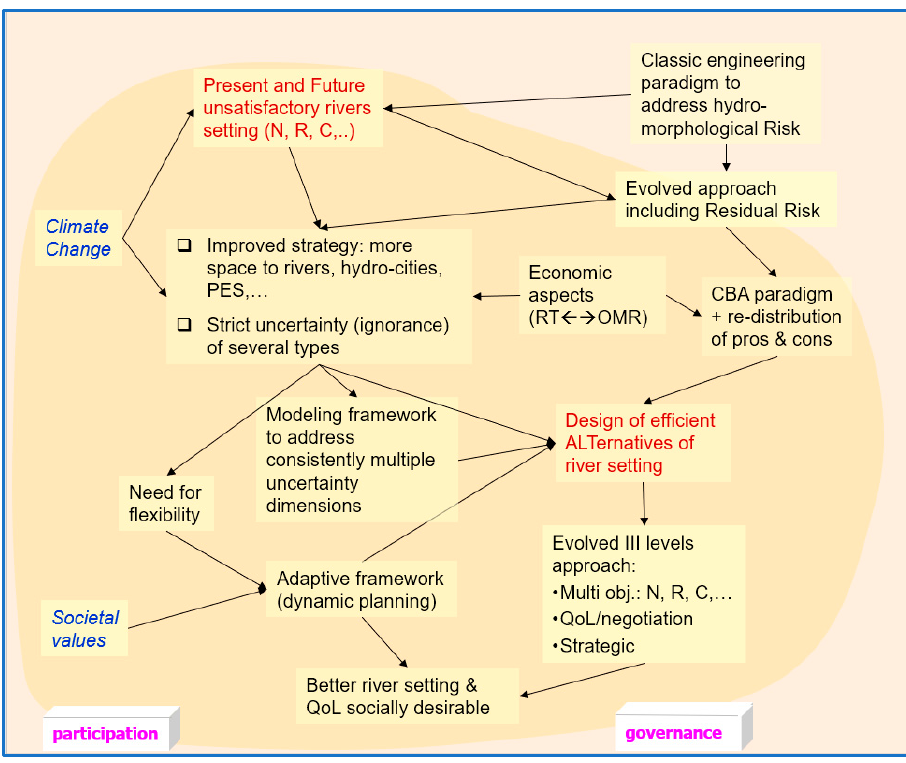
Figure 18. The reasoning developed in this paper (see text for explanation).